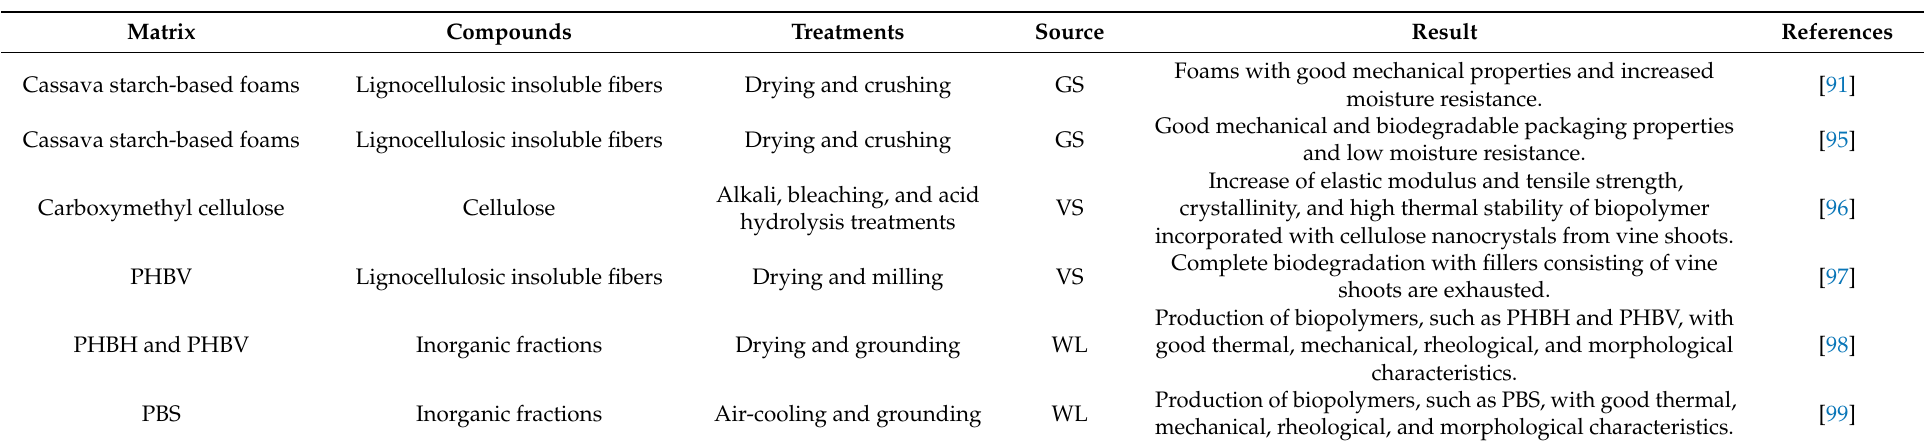
Table 2. Applications of wine by-products as filler to improve food